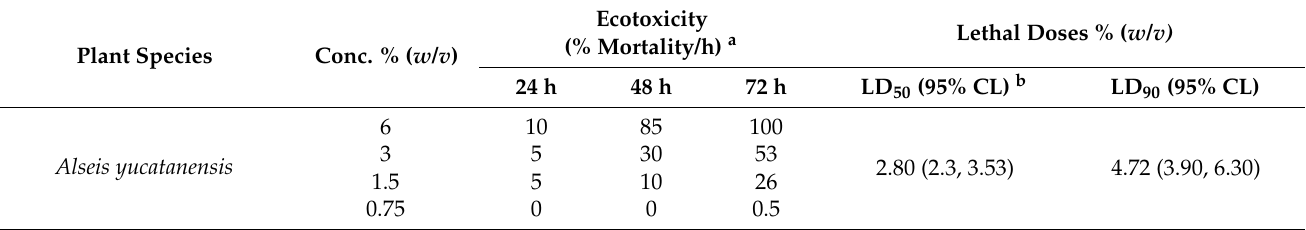
Table 4. Ecotoxicity and lethal doses (50 and 90) of nematicide aqueous extracts (leaves) against Eisenia fetida (one/vial, 20 replicates), after 72 h